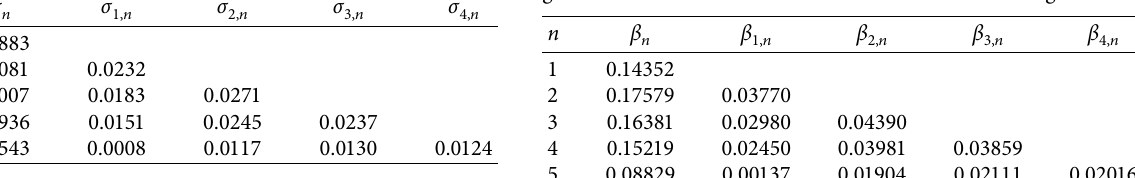
Table 18: Overall belief values of risk information fusion at all risk grades and the belief values at the intersection of risk grades.